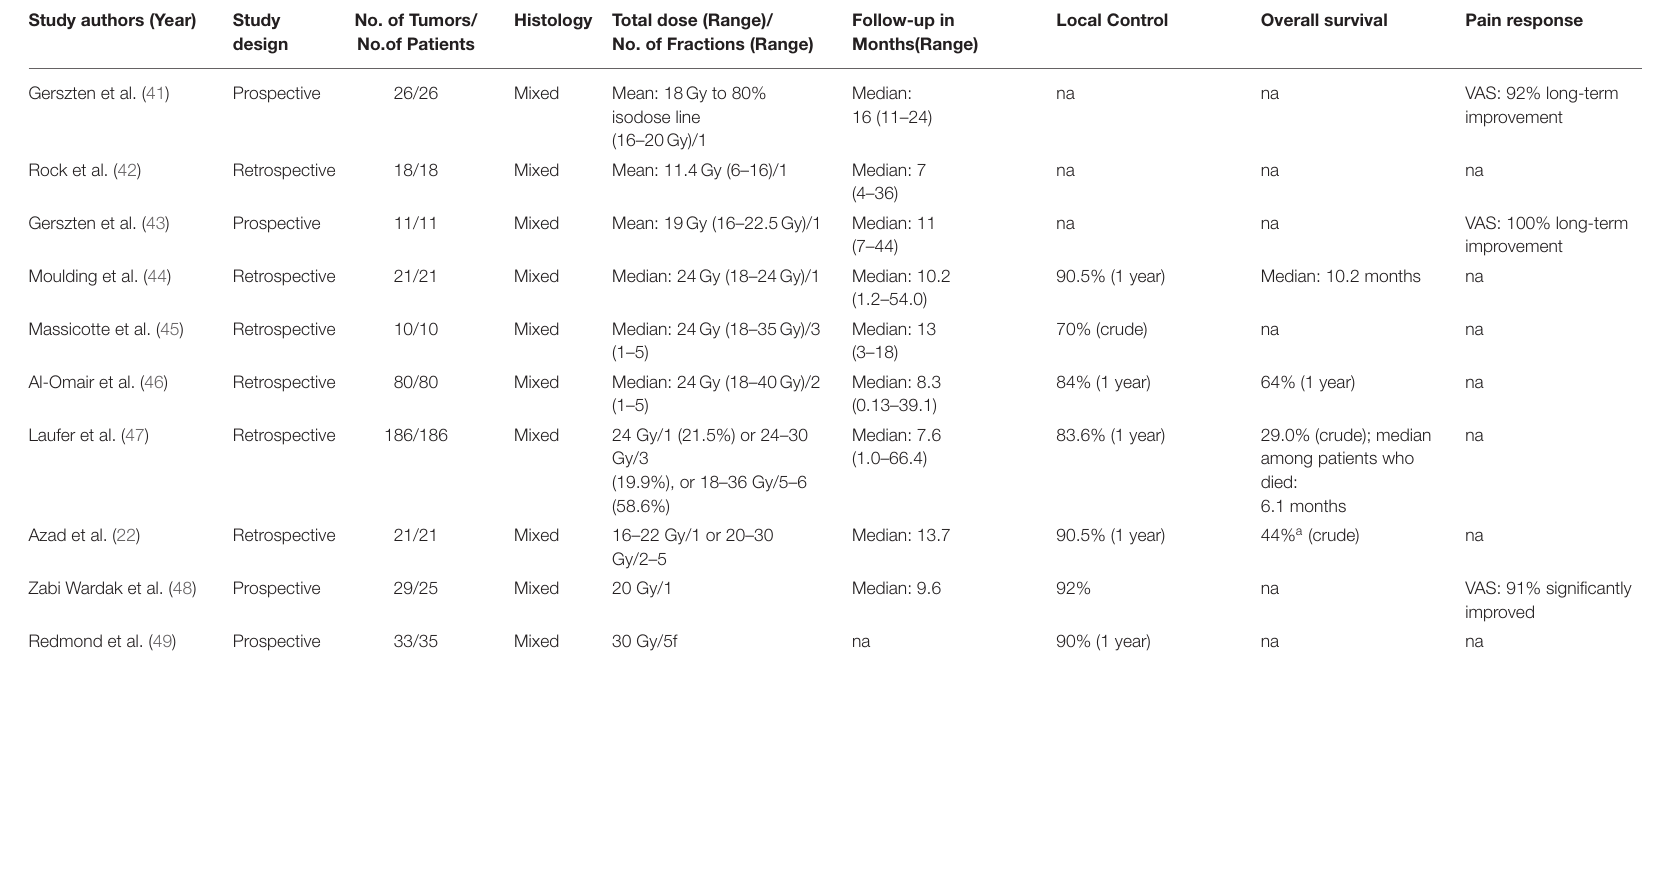
TABLE 3 | Selected postoperative spine SABR series for spinal